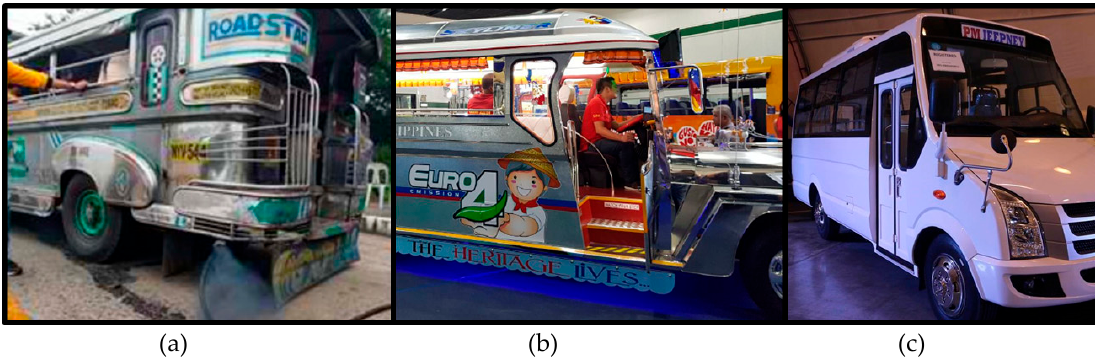
Figure 1. Most common public utility vehicles in the Philippines: ( a ) traditional diesel jeepney; ( b ) modernized diesel jeepney with Euro 4-compliant engine; ( c ) air-conditioned e-jeepney. Source: Land Transportation Franchising and Regulatory Board